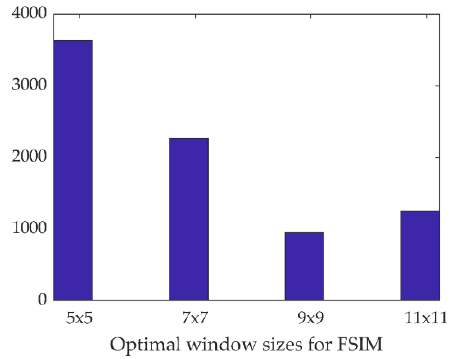
Figure 7. Numbers of test images with different optimal window sizes according to FSIM.